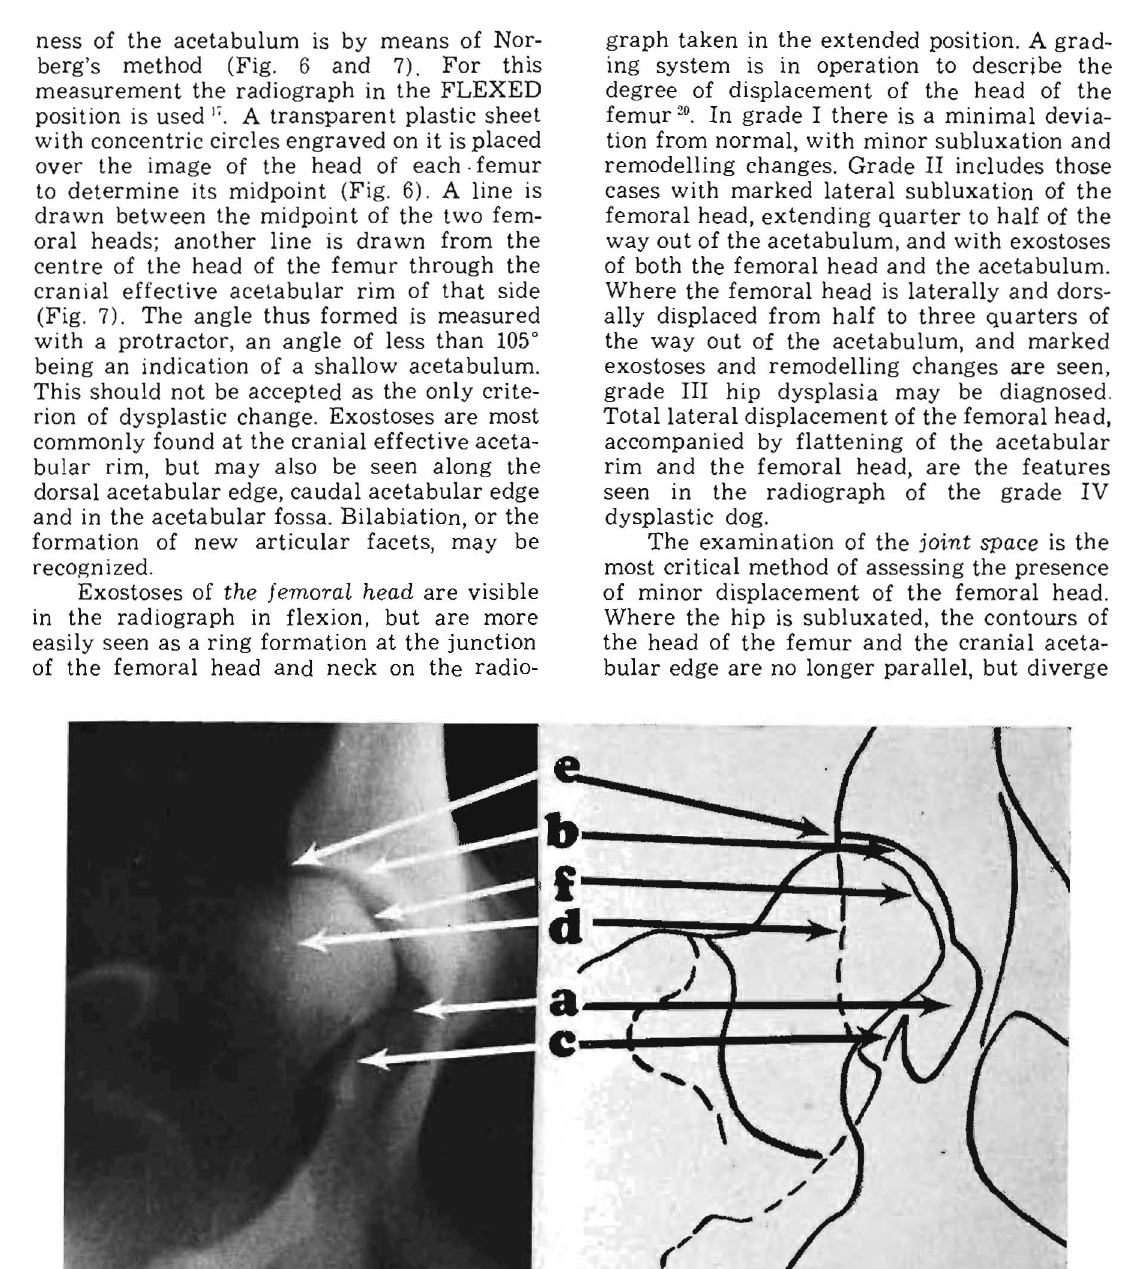
Figs. 4 and 5: Radiographic anatomy of the hip joint. (a) Acetabular fossa. (b) Cranial acetabular edge. (c) Caudal acetabular edge. (d) Dorsal acetabular edge. (e) Cranial effective acetabular rim. (0 Fovea